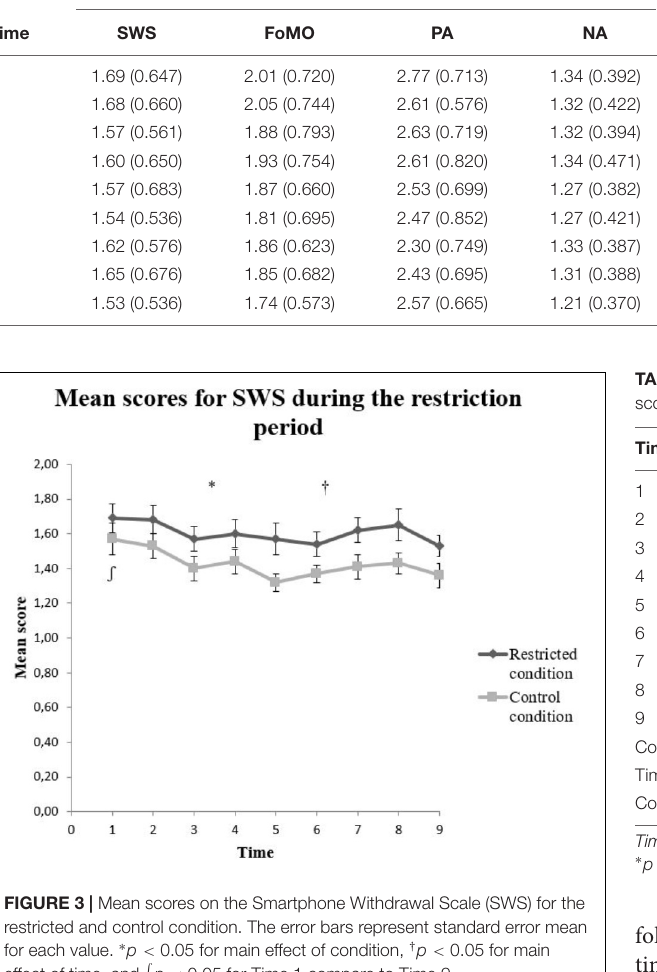
TABLE 3 | The mean and standard deviation for each condition on the SWS, FoMOS, and PANAS at Time 1–9. Restricted